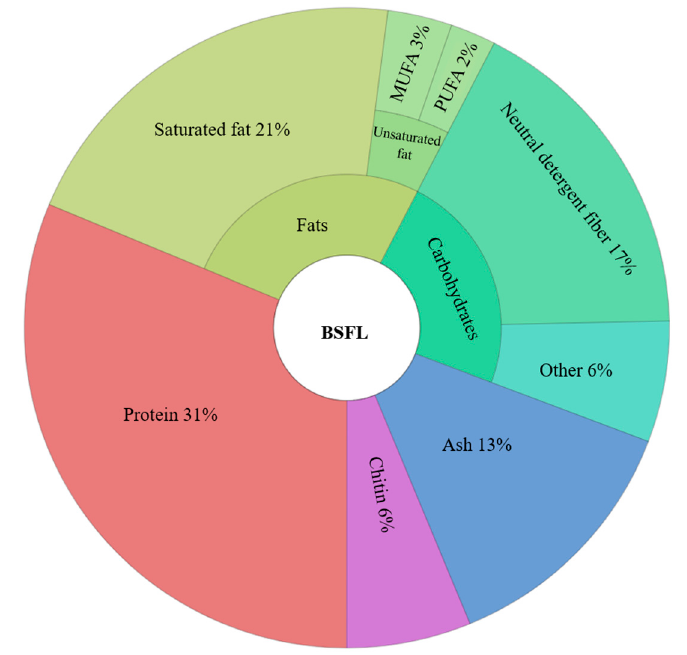
Figure 1. Krona chart of the proximate composition of black soldier fly larvae (BSFL) (adapted from [11]).